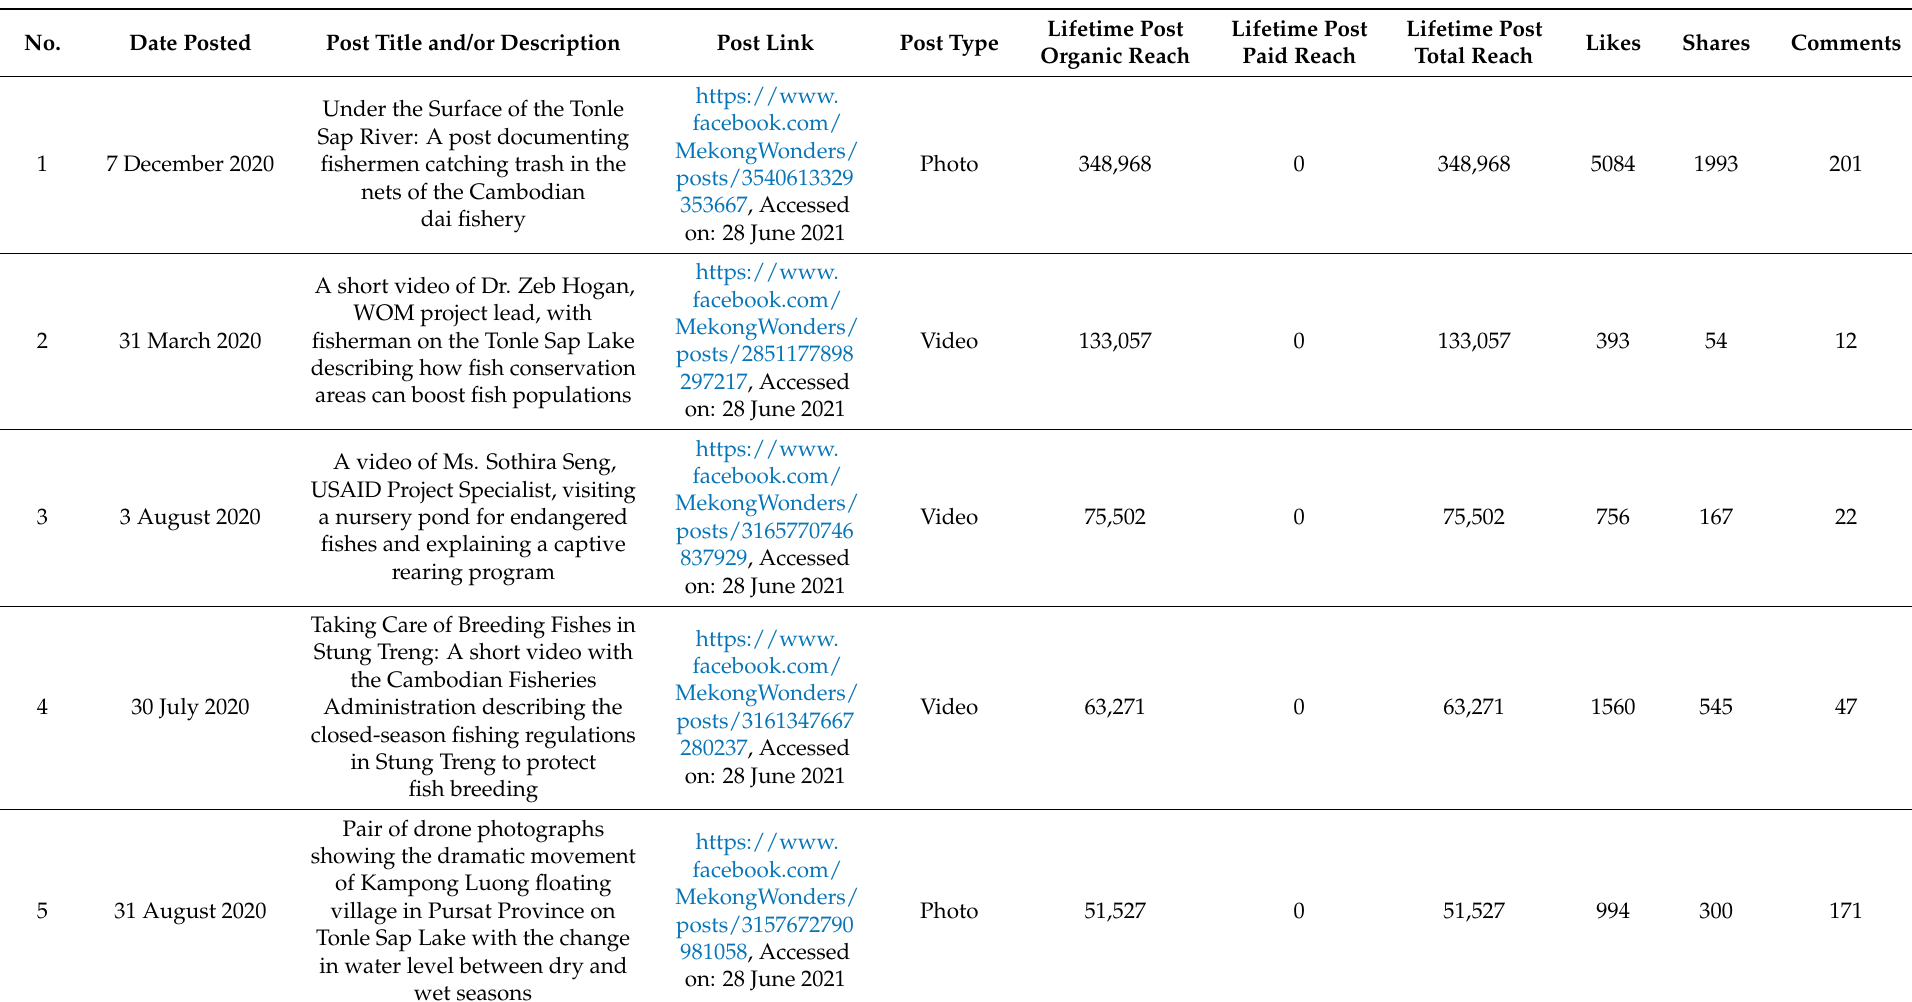
Table 4. Engagement metrics for the 20 most popular WOM Facebook posts based on nonpaid (organic) reach. Paid reach refers to the viewers who saw a subset of posts that were boosted with paid